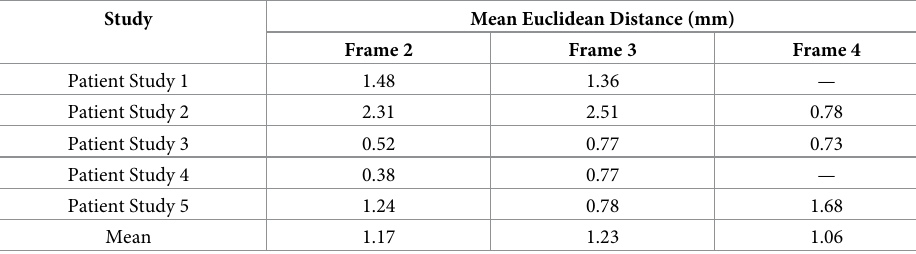
Table 1. Mean Euclidean distance between reference and transformed point source